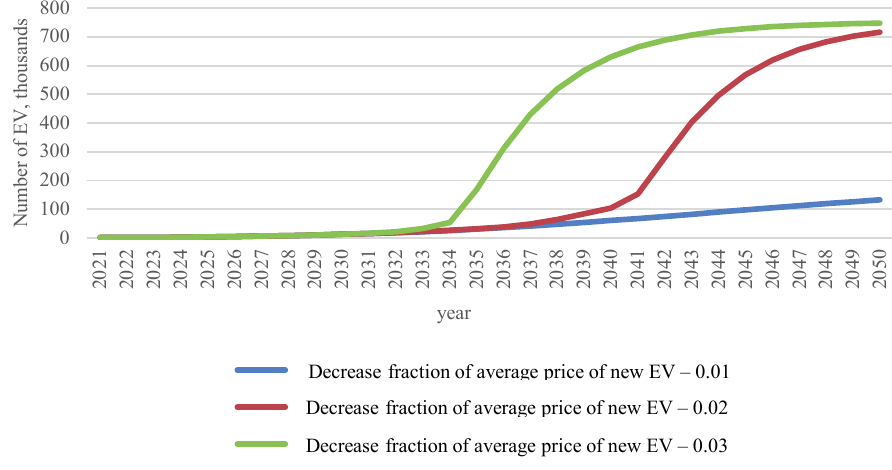
Fig. 5. Electric vehicle growth dynamics depending on the rate of average prices decrease rate of new EV. Average price decrease for the base scenario is